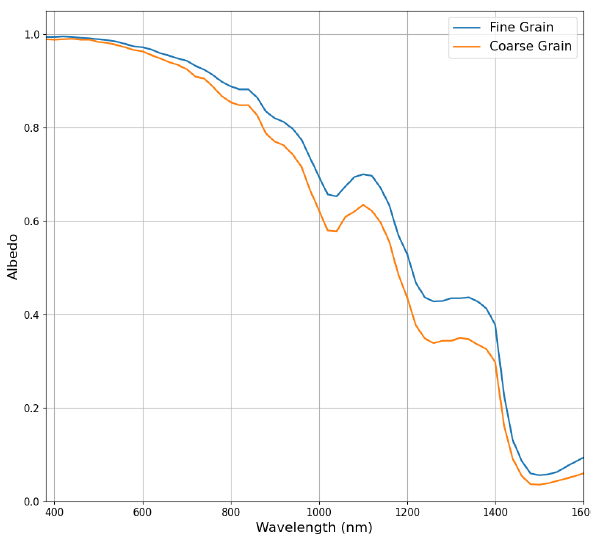
Figure 8. Simulated spectral albedo for fine-grain and coarse-grain snow samples for 100% diffuse radiation. Note these simulations were run with 25000 photons for a snow depth of